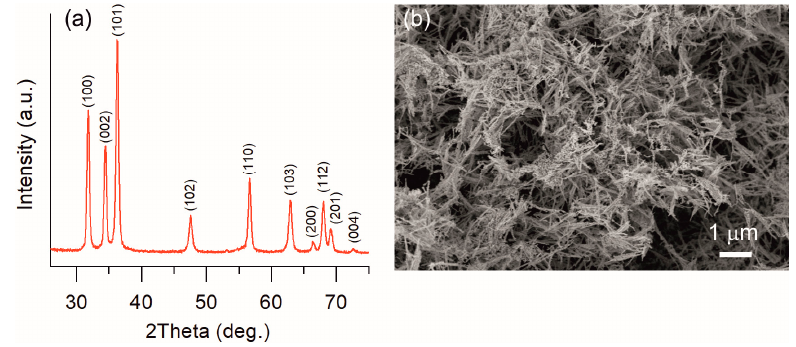
Figure 1. ( a ) XRD pattern of the ZnO nanostructure, ( b ) SEM images of the ZnO.